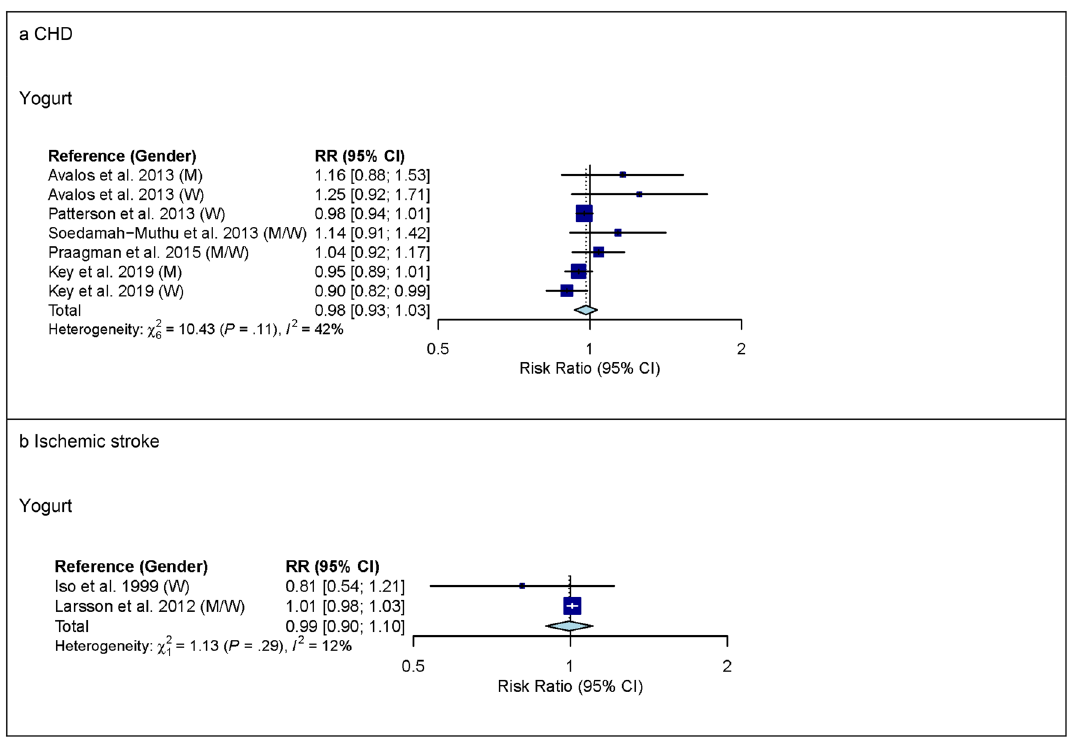
Figure 2. Linear dose–response meta-analysis. Summary RR of CHD (panel a ) and ischemic stroke (panel b ) per 100 g higher intake of yogurt/day. Yogurt defined as yogurt/other soured milk products. CHD coronary heart disease; CI confidence interval; M males; RR risk ratio; W